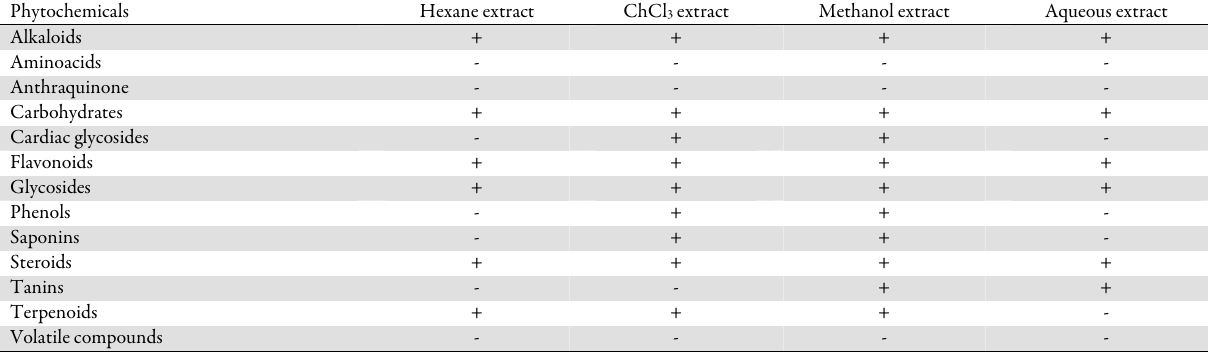
Table 3. Phytochemical constituents of Rauwolfia serpentine roots Phytochemicals Hexane extract ChCl 3 extract Methanol extract Aqueous extract Alkaloids